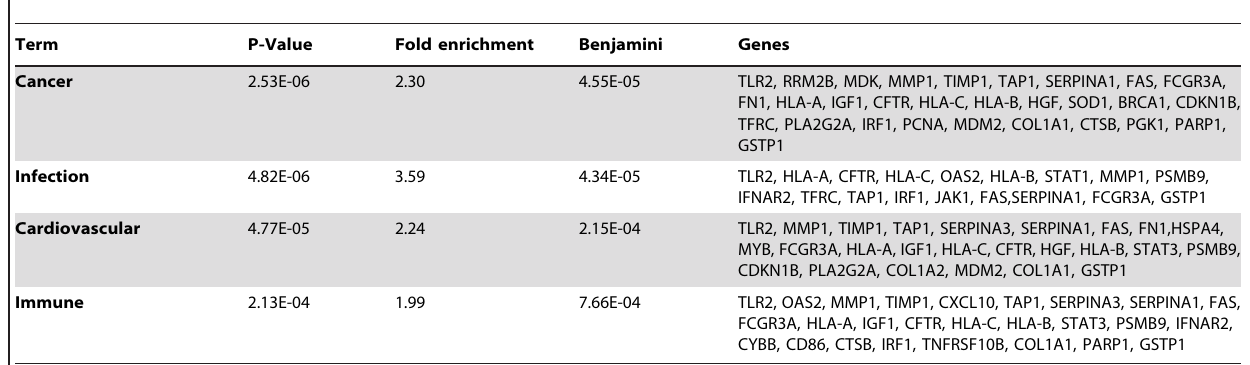
Table 1. GENETIC_ASSOCIATION_DB_DISEASE_CLASS analysis of 82 genes in TF-gene regulatory network.